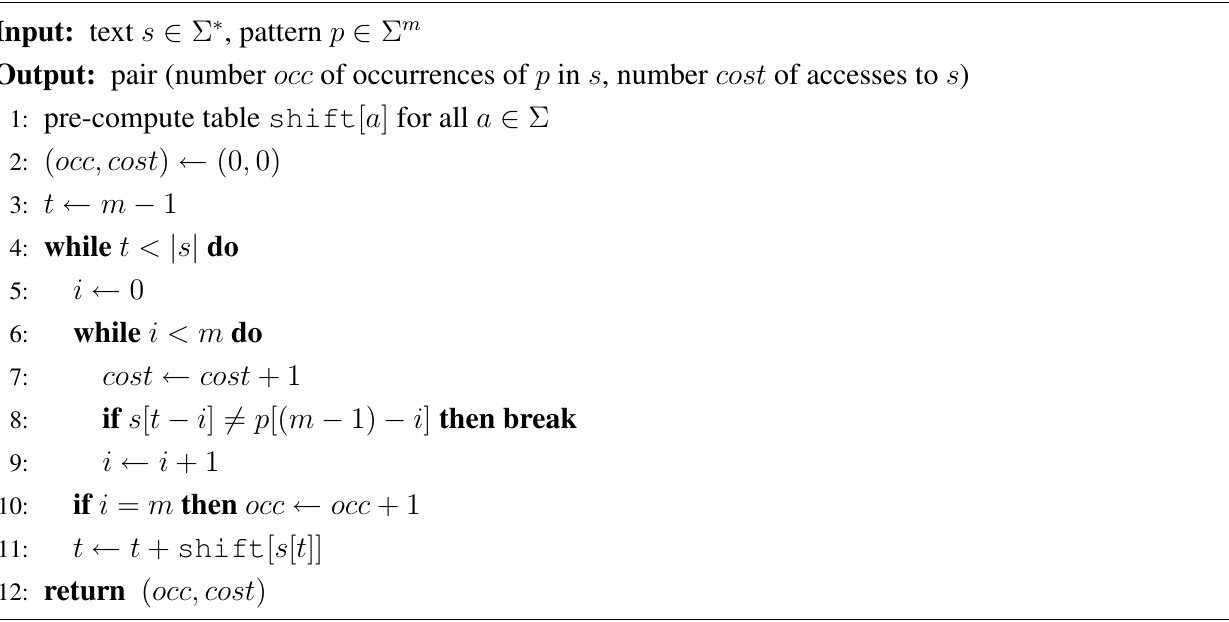
Algorithm 1 H ORSPOOL - WITH -C